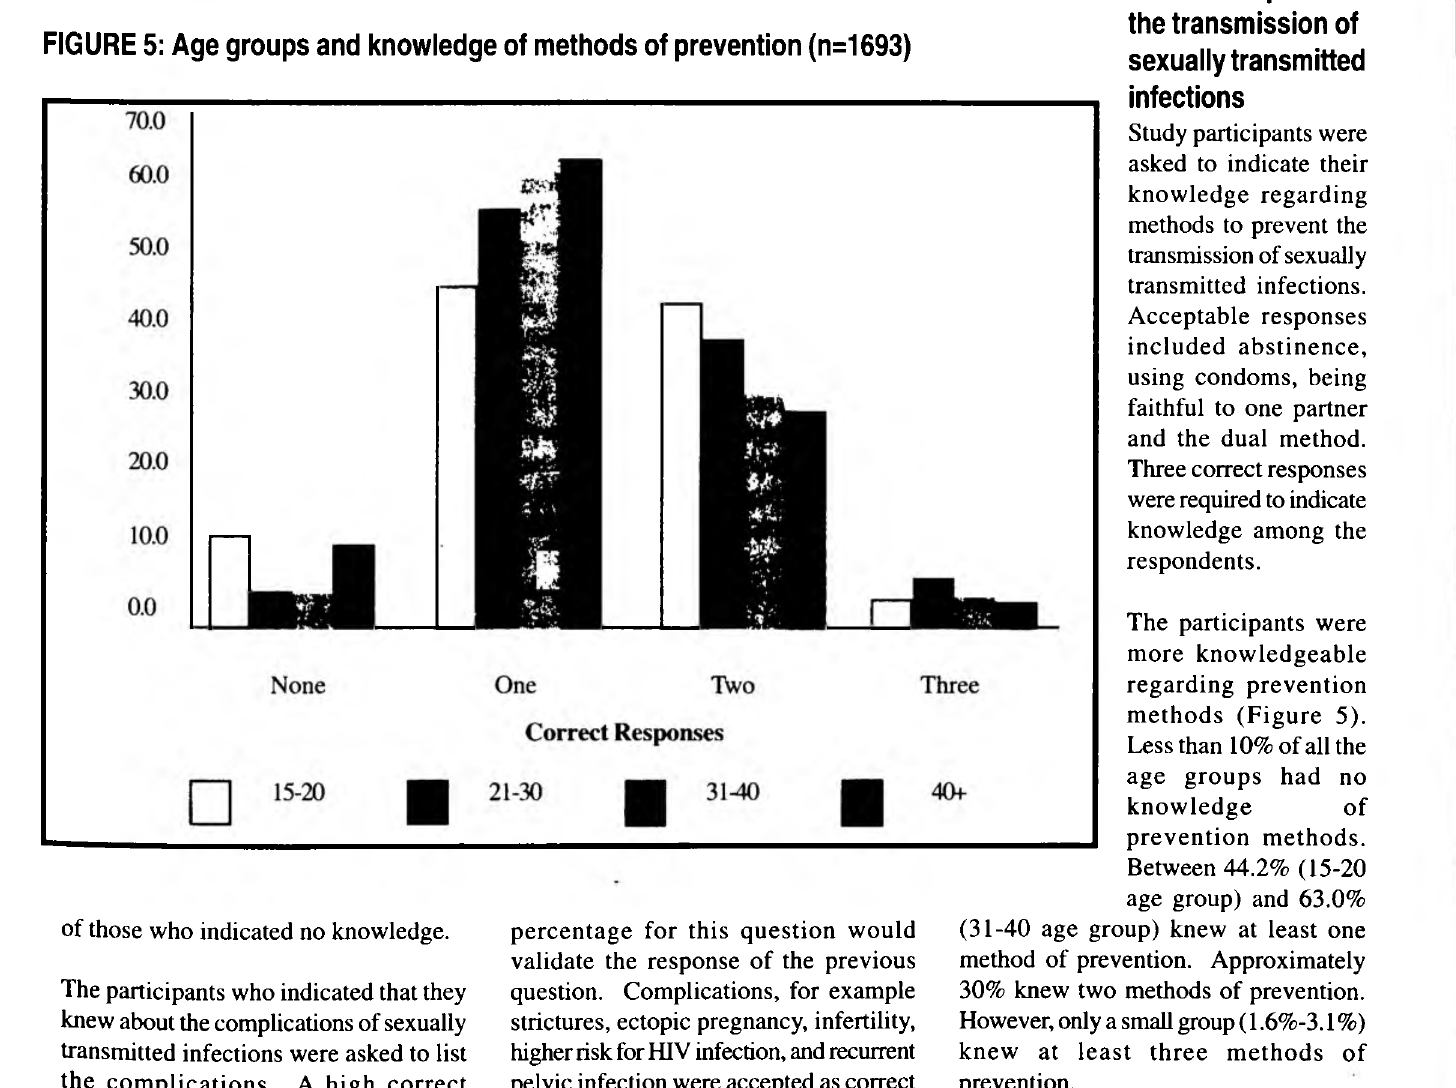
FIGURE 5: Age groups and knowledge of methods of prevention (n=1693)